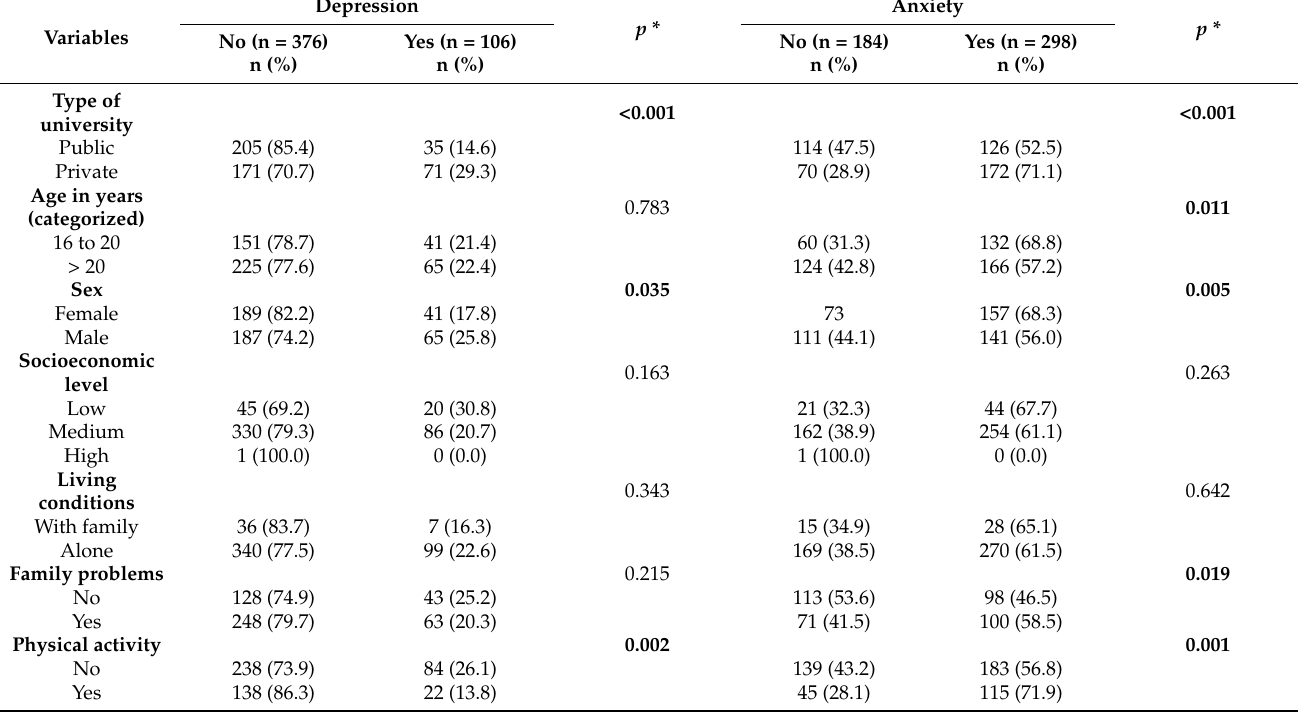
Table 2. Factors associated with depression and anxiety in medical students in Lambayeque,